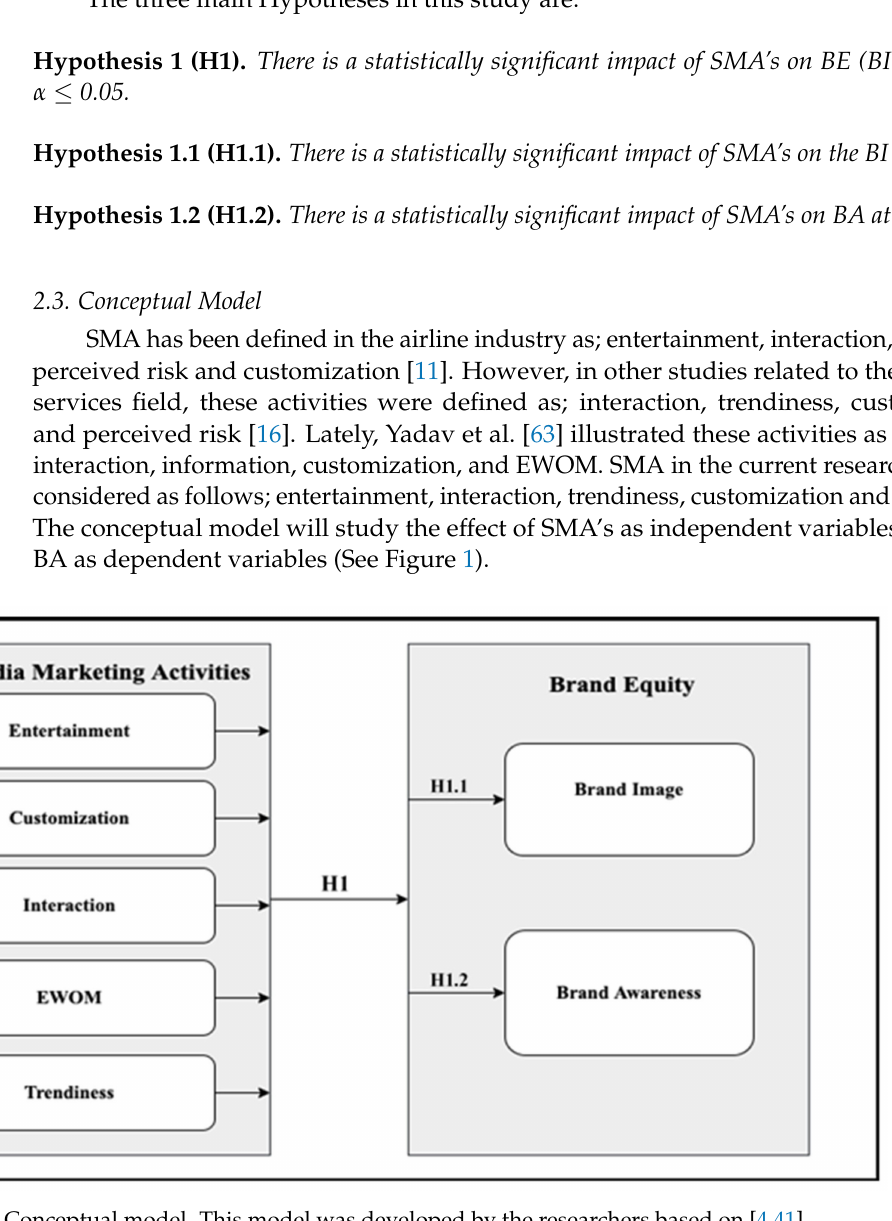
Figure 1. Conceptual model. This model was developed by the researchers based on